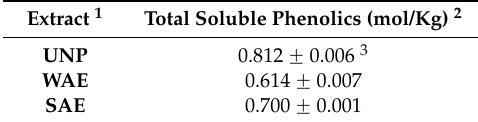
Table 1. Effect of anionic resin treatments on the phenolic contents of water-soluble thyme extracts.